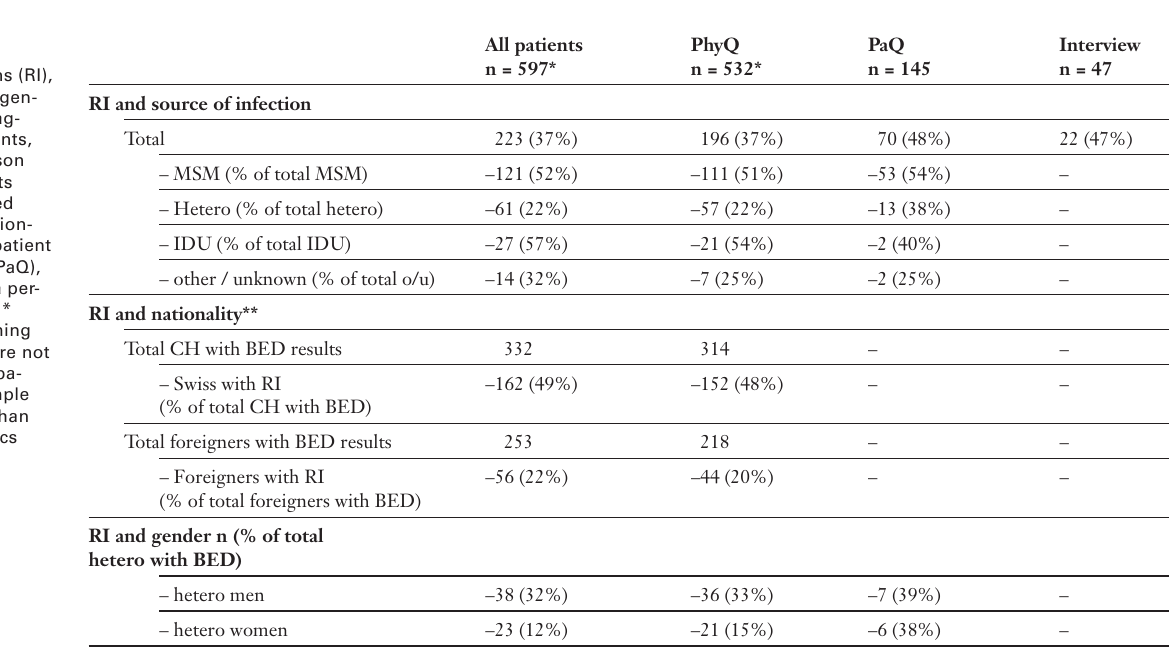
* BED results (timing of infection) were not available in all patients. Total sample size is smaller than for demographics (table 1) ** Swiss nationality = all Swiss nationals and patients with permanent residence in Switzerland >10 years